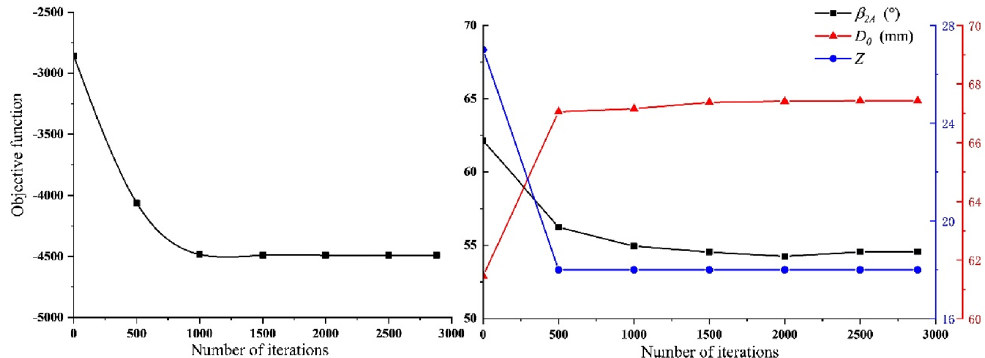
Figure 16. Optimization of objective function and design variables.